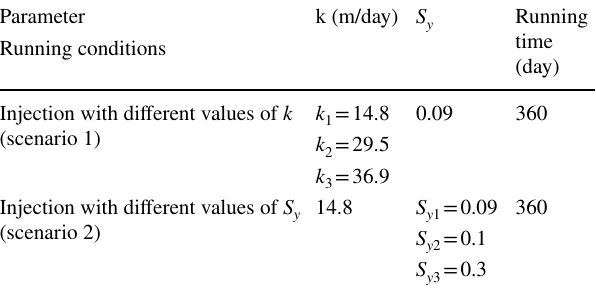
Table 2 Running conditions of IGA simulation model under